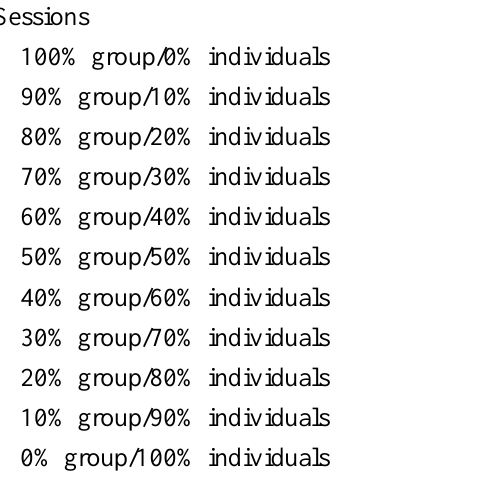
Percentage of Weekly Group Sessions Undertaken by Survey Respondents Individual and group session workloads